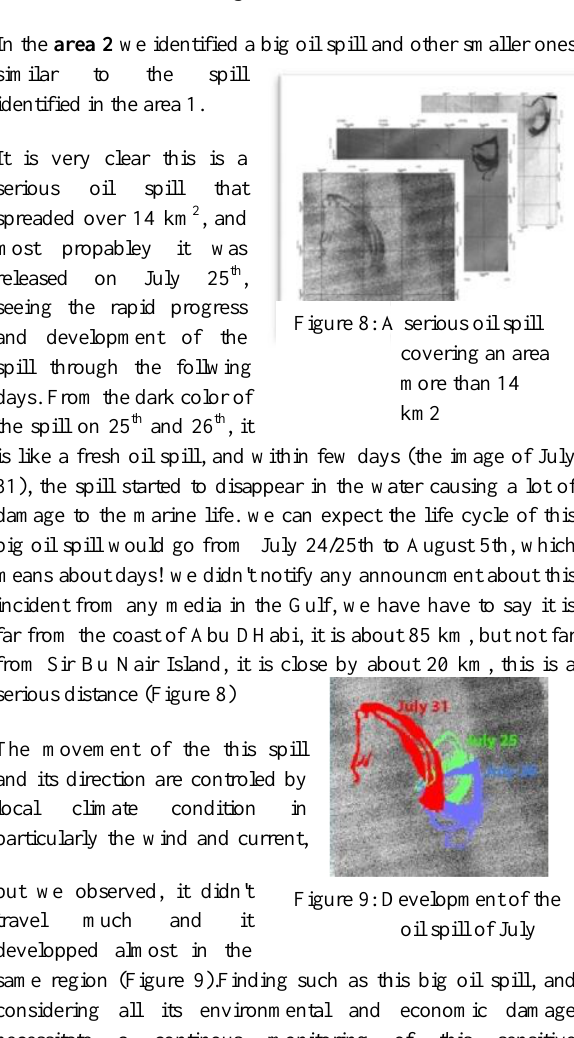
Figure 9: Development of the oil spill of July